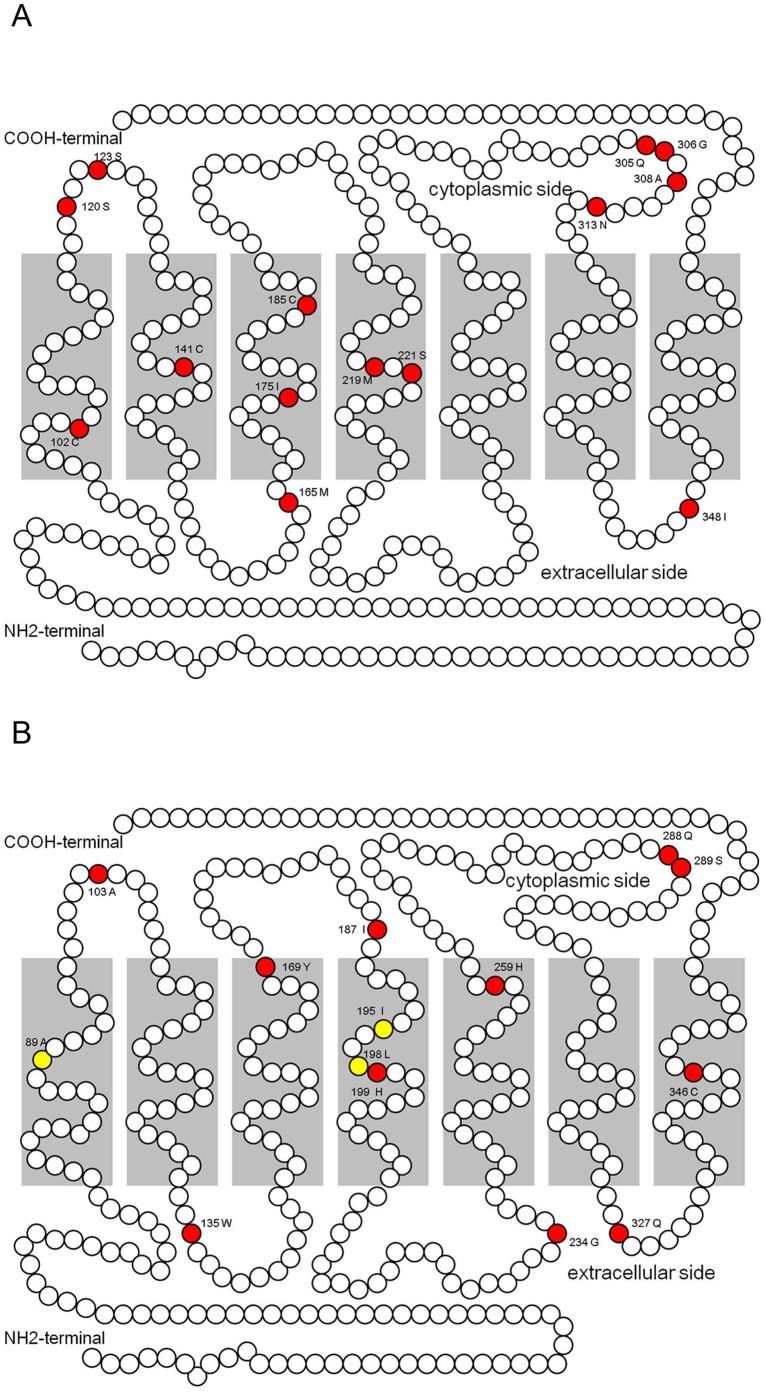
Mapping of positively selected sites on the secondary structure of opsin LW1 (A) and LW2 (B) in Ceratosolen solmsi.Positively selected sites determined with site models and branch-site models are highlighted in yellow and red, respectively.